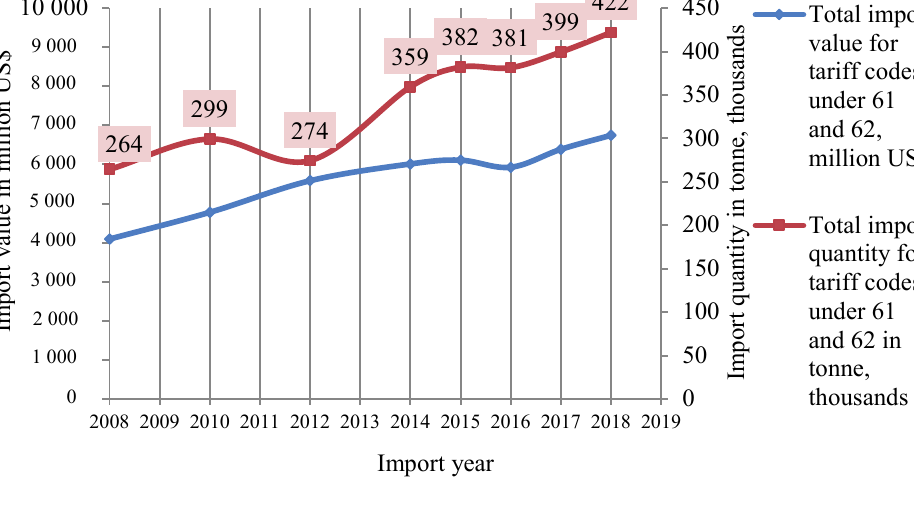
Fig. 1. Apparel import quantity and import value for tariff code 61 and 62